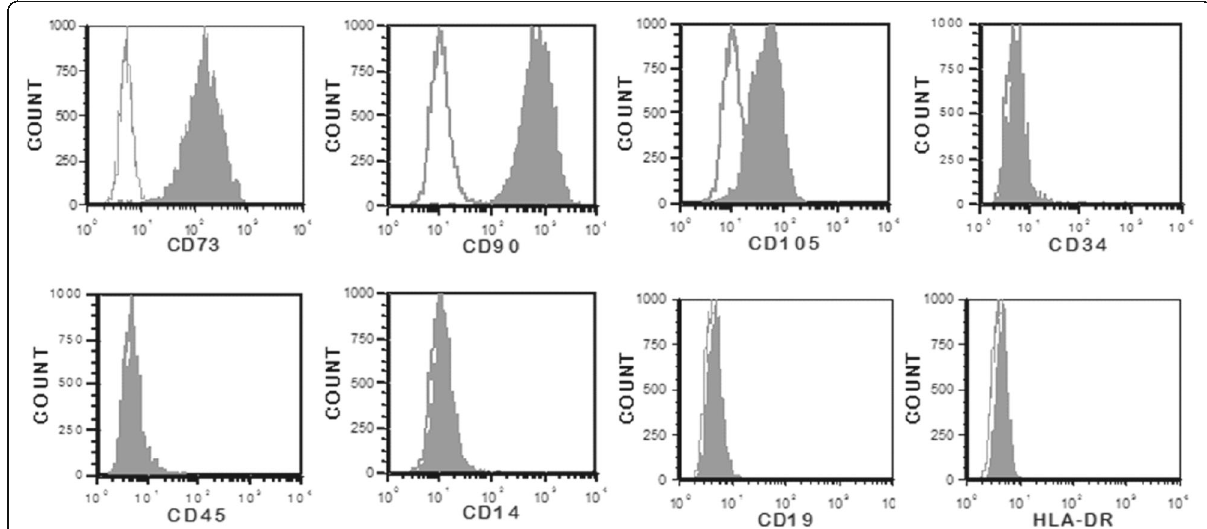
Fig. 1 Representative flow cytometry analysis of FSK-MSC immunophenotype. We used a panel of fluorochrome labelled monoclonal antibodies (mAbs). Empty histograms show the background staining with isotype control mAbs, and solid histograms represent specific staining of the indicated cell surface